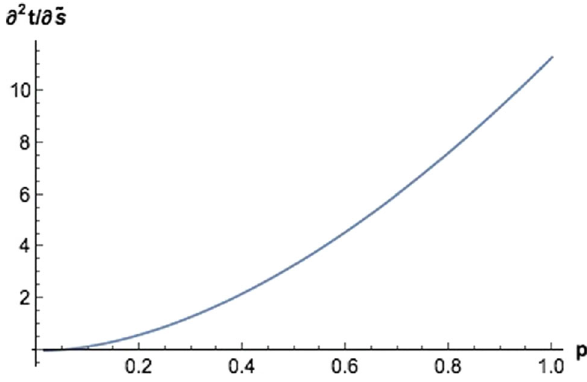
Fig. 6 Behavior of ∂ t /∂ ˜ s , at ˜ s = ˜ s 0 , as a function of the pressure p